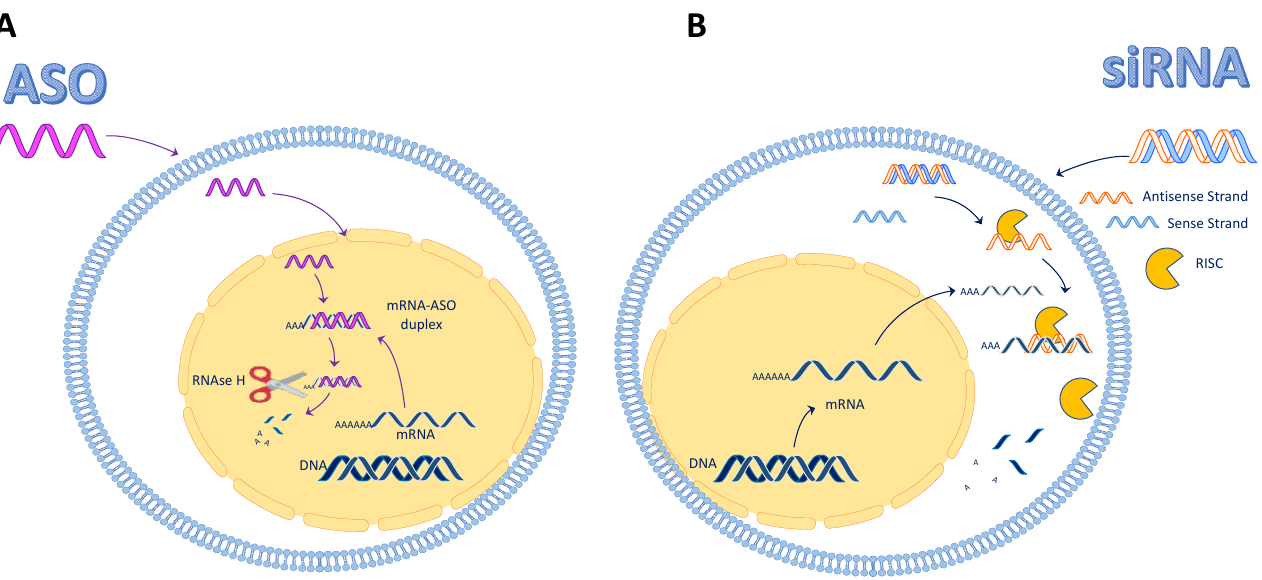
block translation (i.e., peptide nucleic acids (PNAs), O-methyl antisense oligonucleotides (OMOs)) and modulate the splicing of oligomers that do not recruit RNAse H.